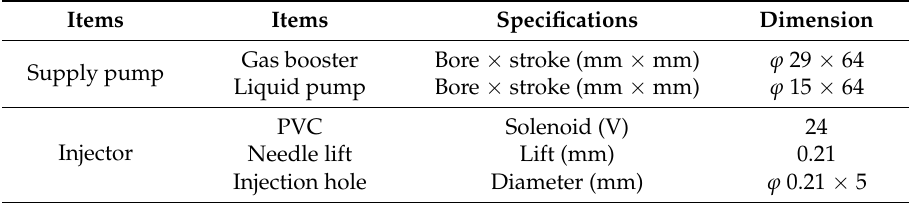
Table 3. DME common rail specifications.